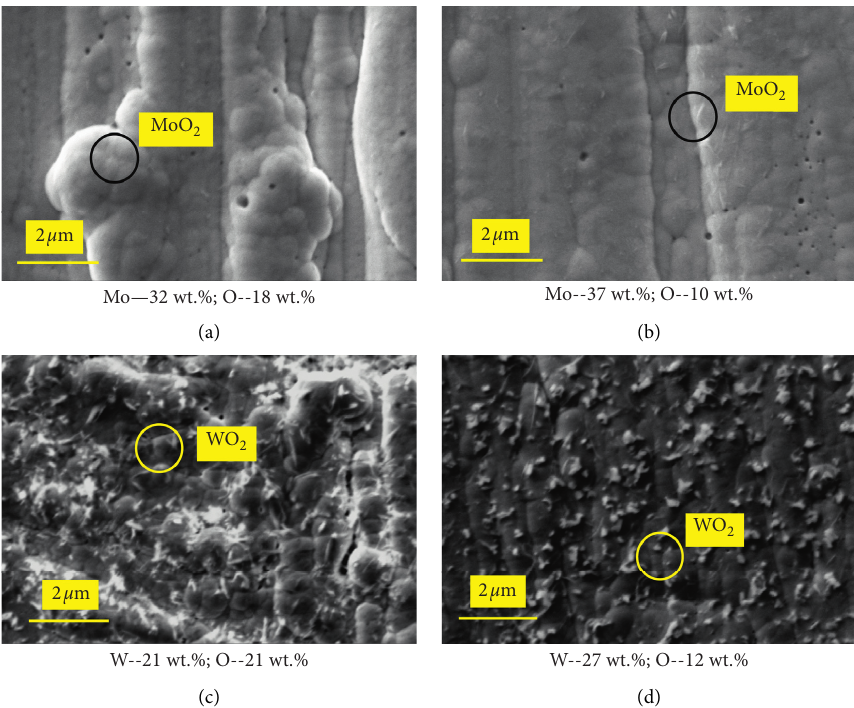
Figure 1: The surface morphology of the Fe-Mo (a, b) and Fe-W (c, d) coatings deposited on the cast iron at dc (i) � 3.5 A /dm 2 (a, c); at pc (i) � 5.5 A /dm 2 ; ( t ) on /( t ) off � 5/20 ms (b,